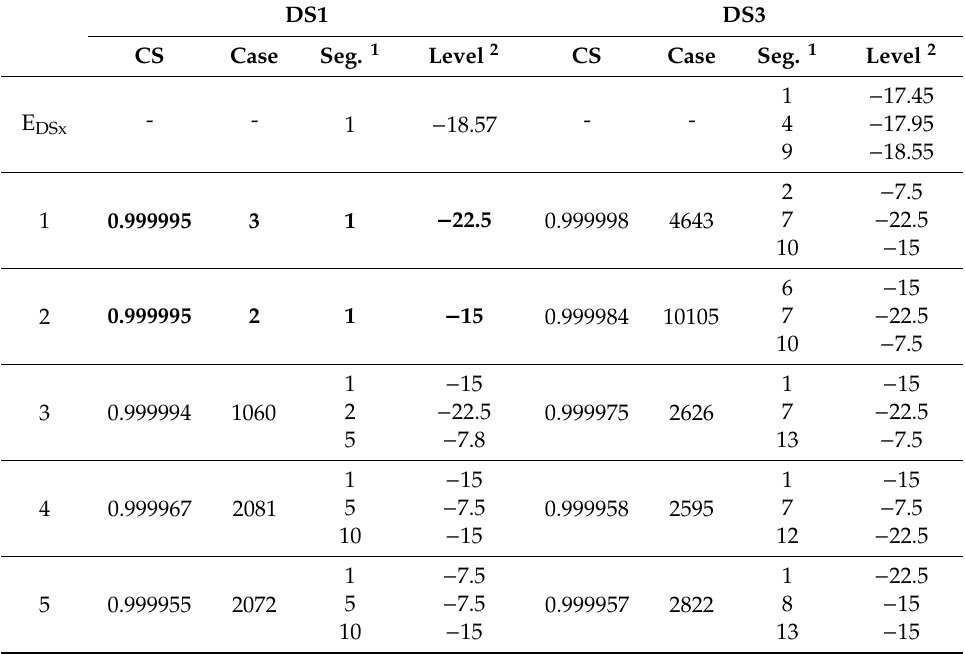
Table 9. The top five damage cases in cosine similarity with the first to third natural frequencies of the symmetric baseline